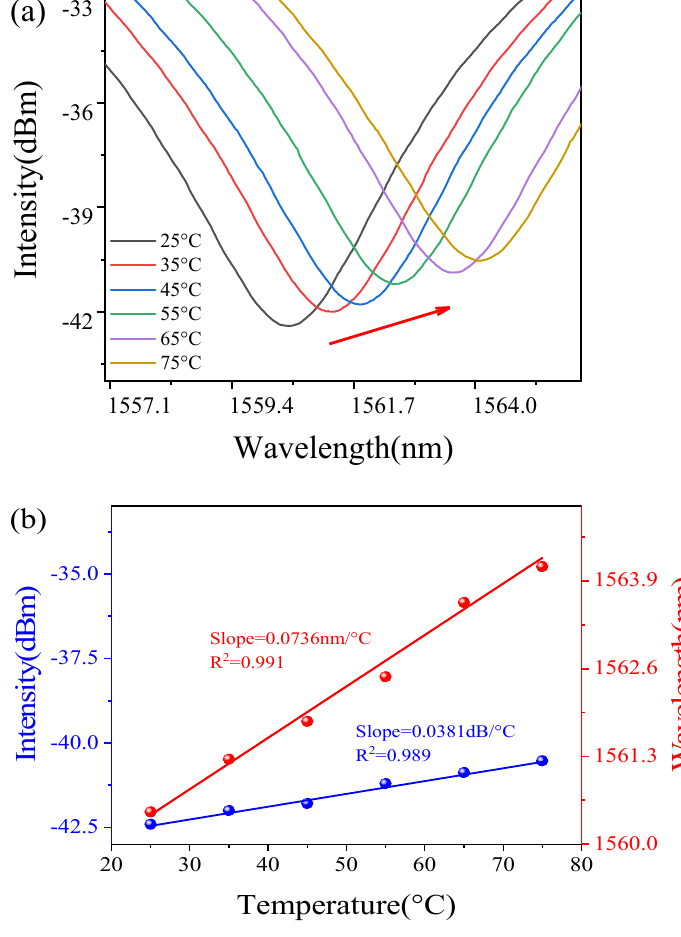
Figure 8. ( a ) Transmission spectrum of t -TCF structure ( L TCF = 15 mm) with varied temperature and ( b ) the relationship between intensity/wavelength variation and increased temperature.